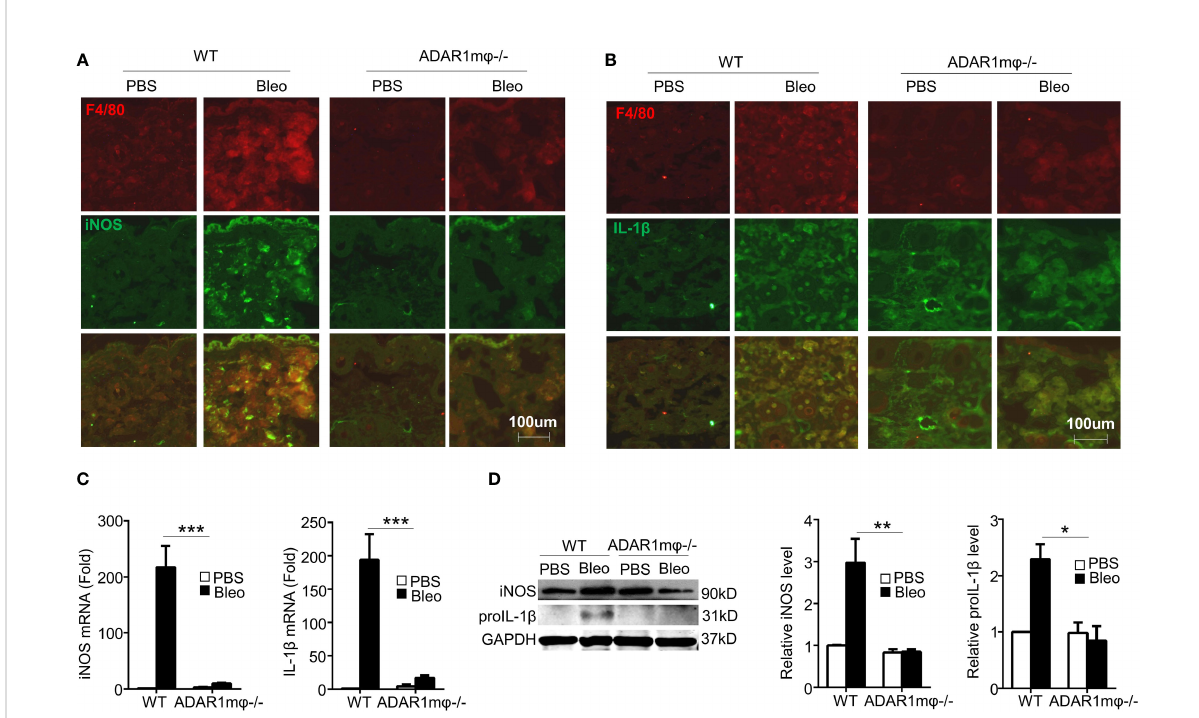
FIGURE 4 Macrophage ADAR1 de fi ciency (ADAR1m j -/- ) modulated in fl ammation in bleomycin induced skin sclerosis. Mice were injected s.c. with bleomycin (Bleo: 0.02U) for 1 day. (A, B) Frozen skin sections were co-immunostained with F4/80 and iNOS antibodies (A) or IL-1 b antibodies (B) . 20x power of objective lens was used to acquire images. (C, D) ADAR1m j -/- attenuated the mRNA and protein expression of iNOS and pro- in fl ammatory cytokines IL-1 b . The mRNA (C) and protein (D) levels of iNOS and IL-1 b in bleomycin-treated mouse skin were quanti fi ed by qPCR and Western blot, respectively. And iNOS and IL-1 b protein levels were normalized to GAPDH. Data shown are the mean ± SD of three independent experiments. *P < 0.05, **P < 0.01, ***P < 0.001 (ADAR1m j -/- vs WT mice with bleomycin injection). 2-way ANOVA was used for comparison among